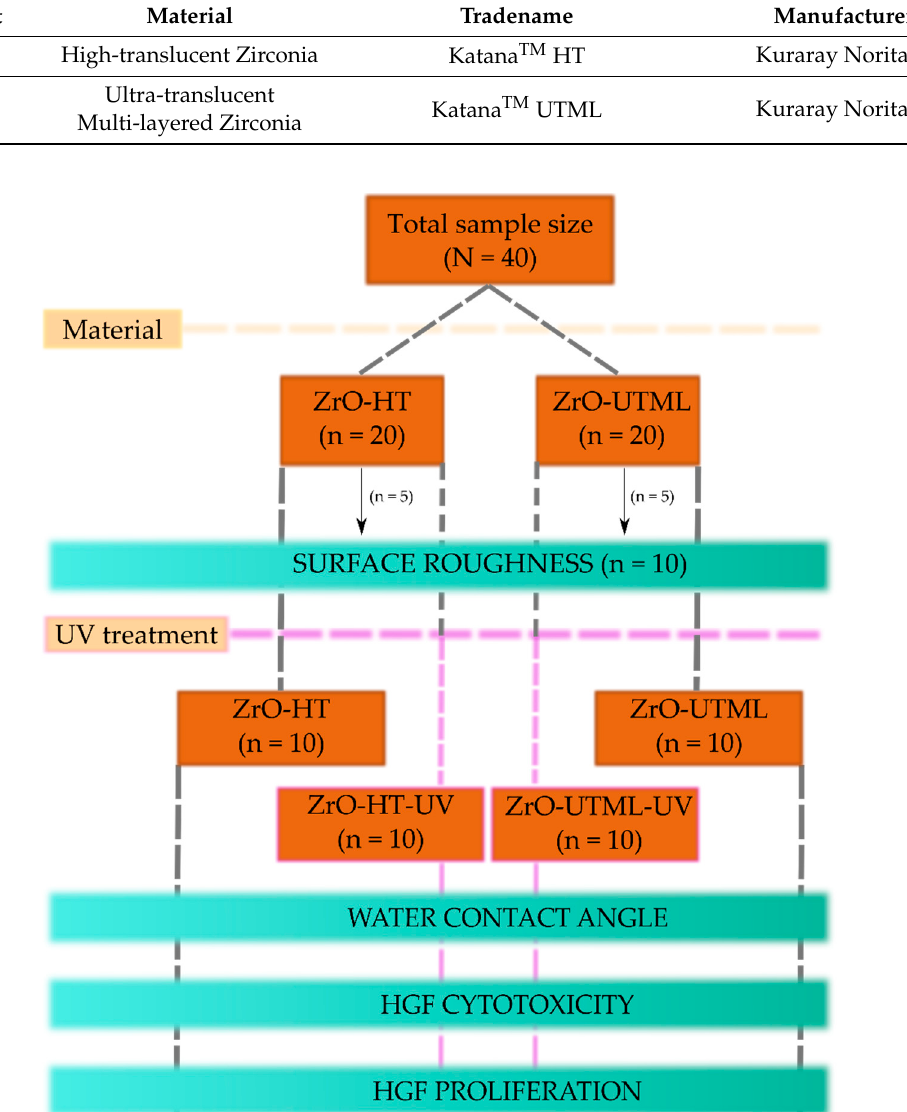
Table 1. Materials, abbreviations used in the text, and their respective manufacturer in the present study.